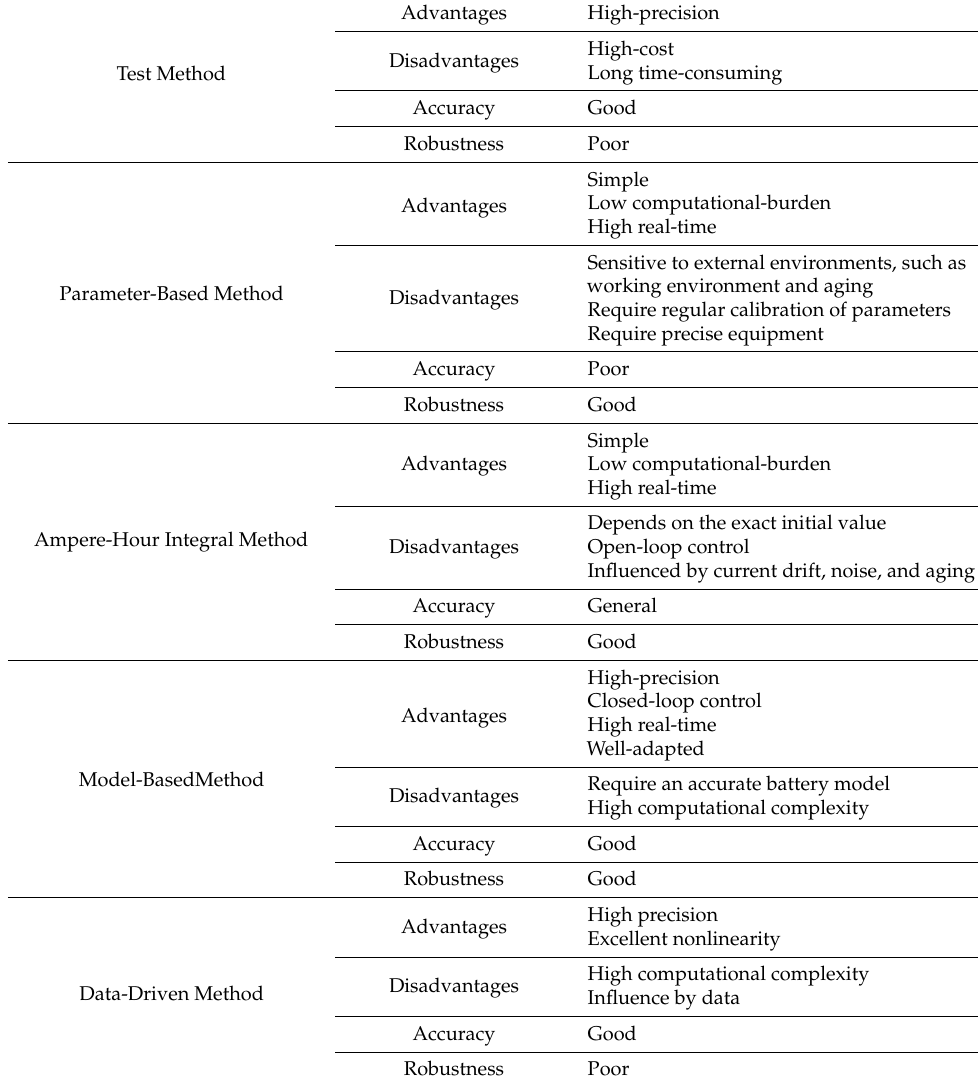
Table 1. The common prediction methods for battery